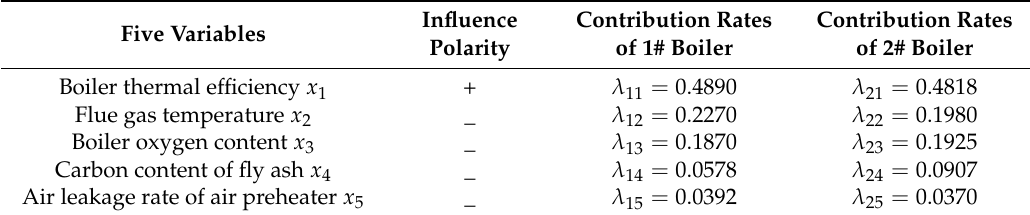
Table 4. The different influence polarity of five variables and its contribution rate values.